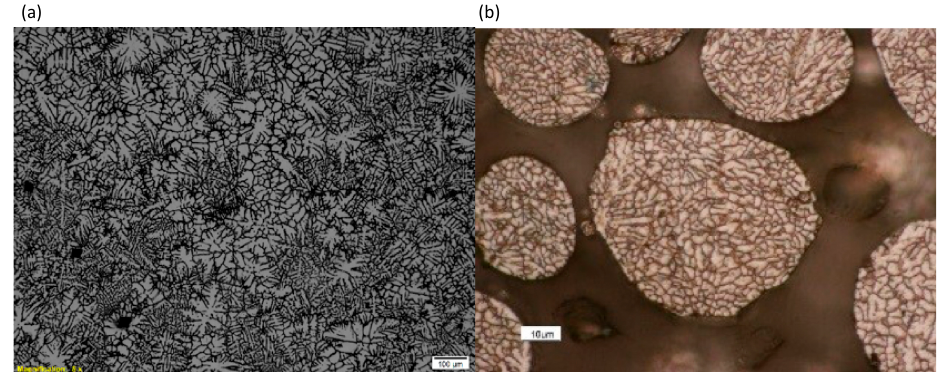
Figure 8. Chemically etched optical micrographs for the ( a ) as-cast and ( b ) as-atomized Al 7075 systems. Note that the scale bar associated with the as-cast chemically etched optical micrograph represents 100 μ m, while the scale bar associated with the chemically etched gas-atomized Al 7075 micrograph was 10 μ m, thus highlighting the difference in microstructural sizes due to differences in cooling rates.